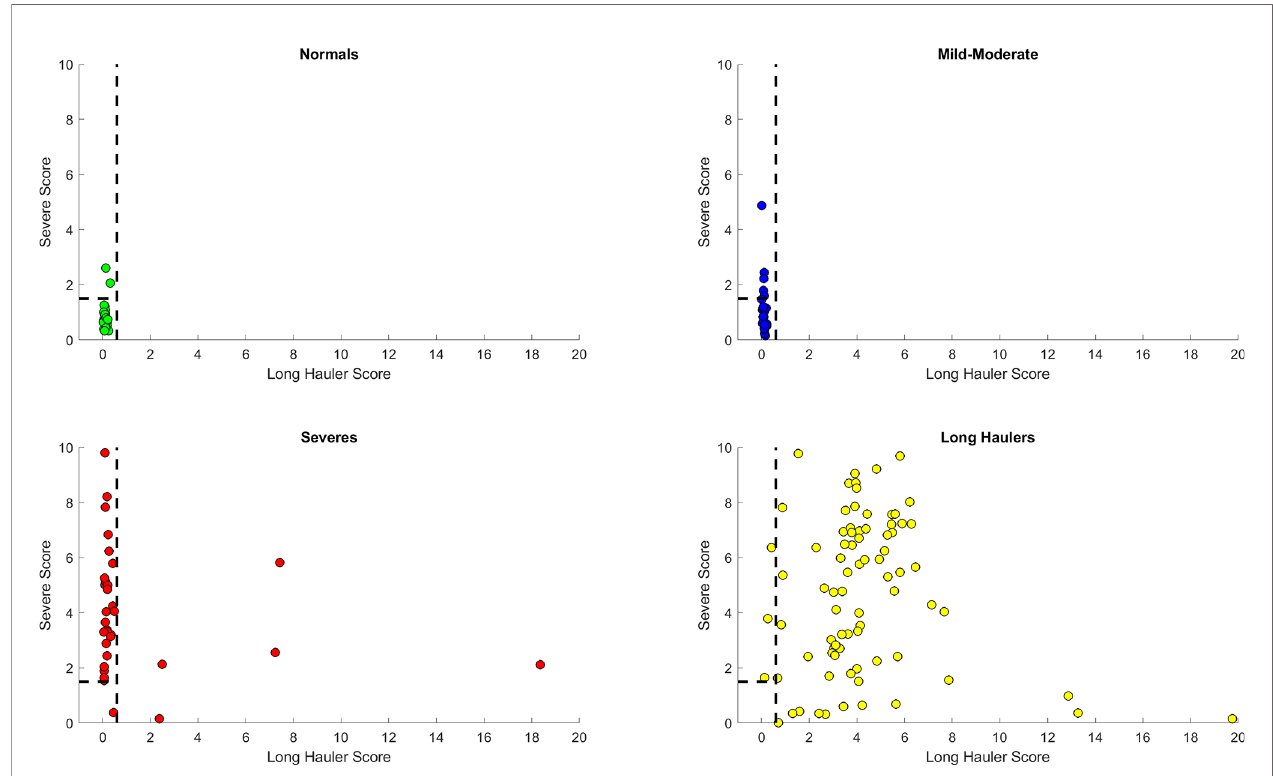
FIGURE 7 | Discrimination ability of the heuristic with both Long Hauler (S1) and Severe (S2) scores. The PASC patients are fi rst identi fi ed with an S1>1.5. From those remaining patients, the Severe cases are identi fi ed with an S2> 1.5. The dots represent the data points, where yellow are PASCs, red-Severe, dark blue-Mild- Moderate and